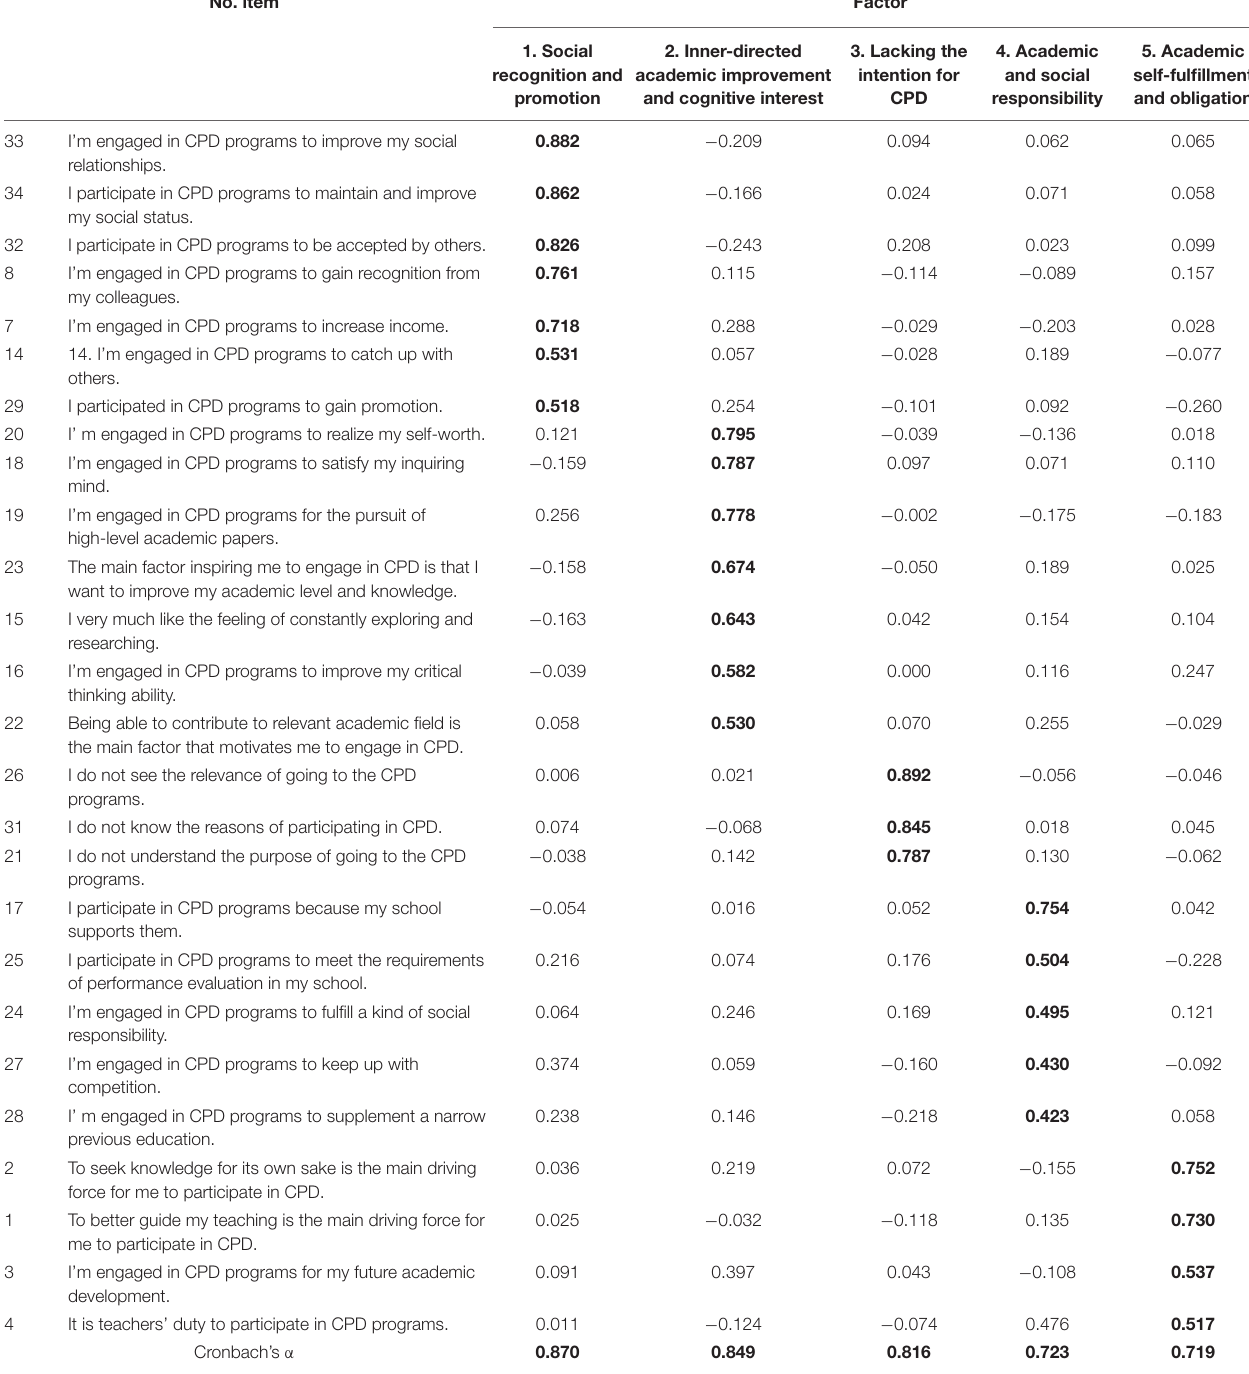
TABLE 2 | Results of EFA for TEFL teachers’ CPD motivation. No.